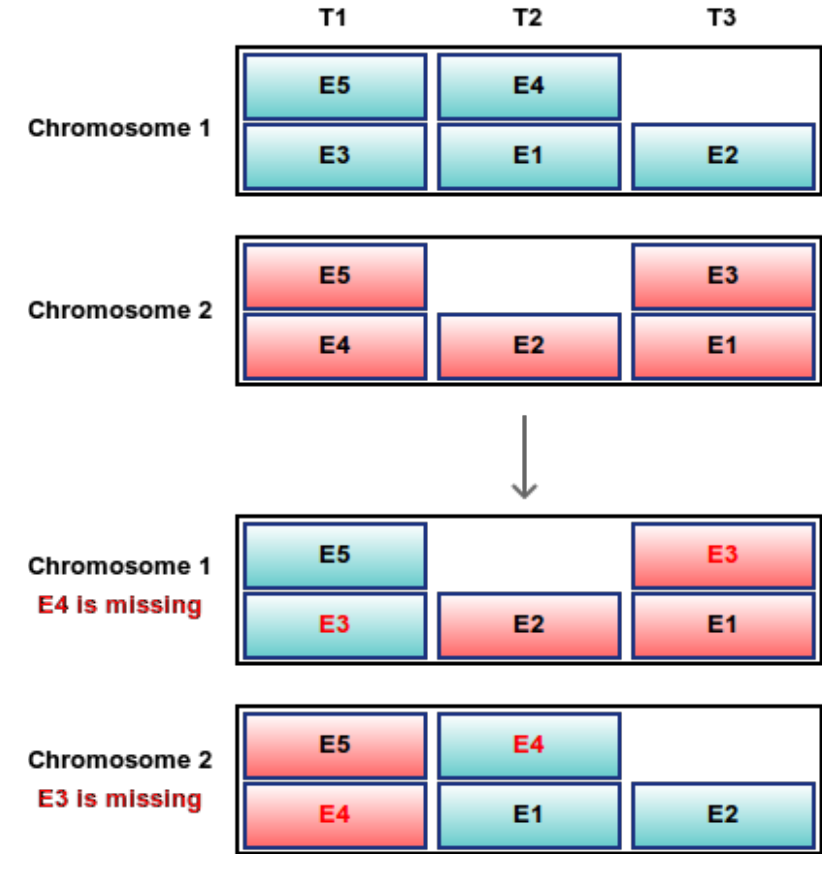
Figure 2. Indirect encoding: single-point crossover between two chromosomes after the first gene. Examinations in bold red are missing or appear twice. E1–E5: examinations; T1–T3: